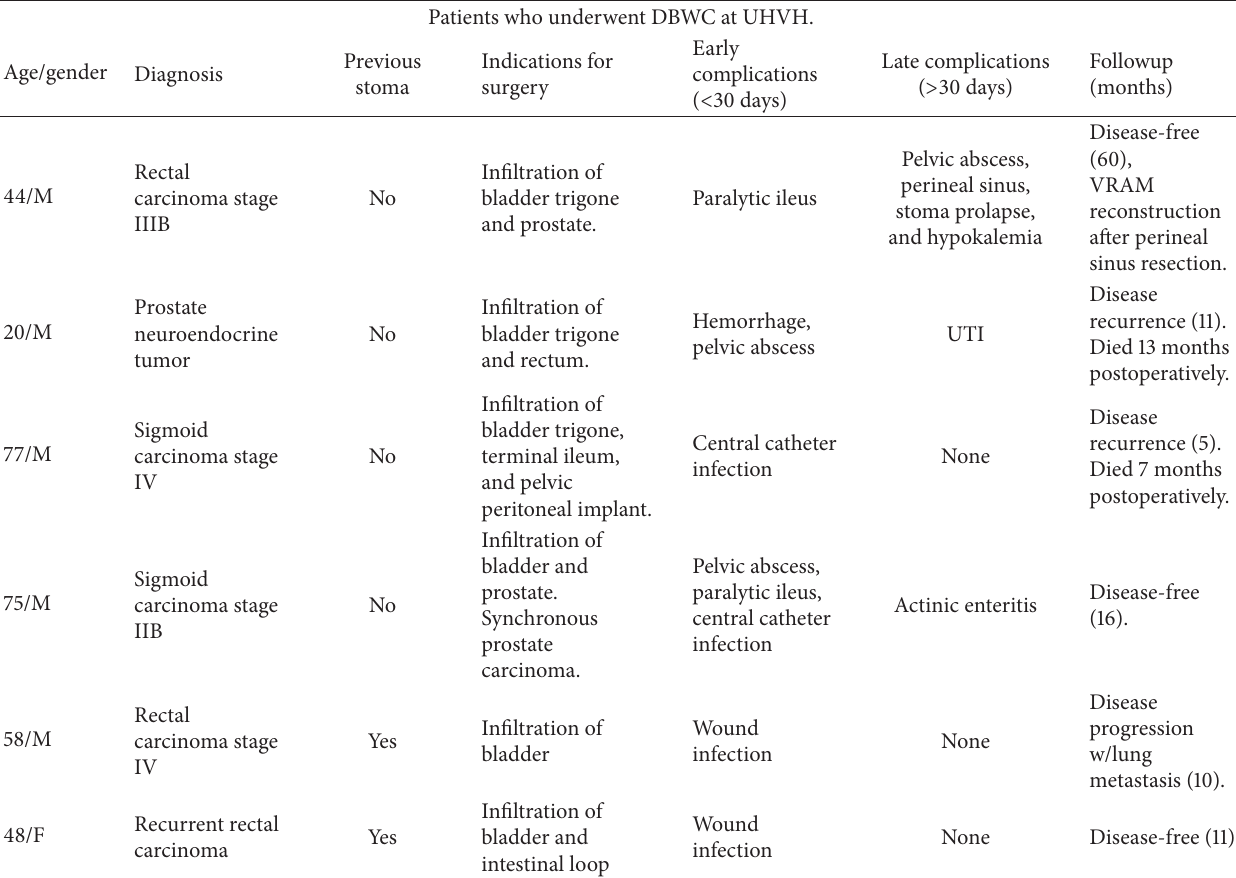
Table 1: Patients with DBWC at University Hospital Vall d’Hebron. UTI, urinary tract infection. Patients who underwent DBWC at